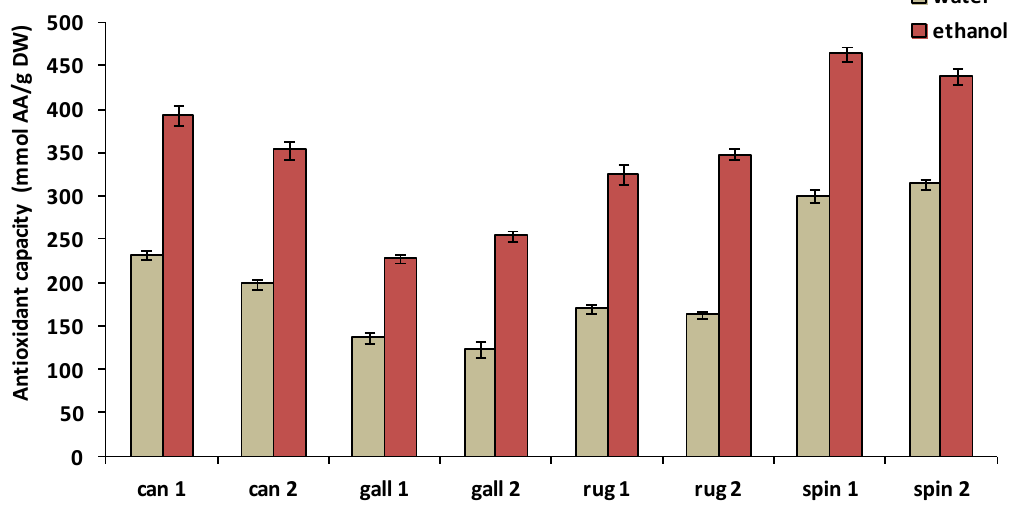
Figure 2. Antioxidant capacity (FRAP) of water and ethanolic extracts of R. canina (can), R. gallica (gall), R. rugosa (rug) and R. spinosissima (spin); means ± SD; 1 = location 1 (Gödöllő), 2 = location 2 (Szeged). AA: ascorbic acid.